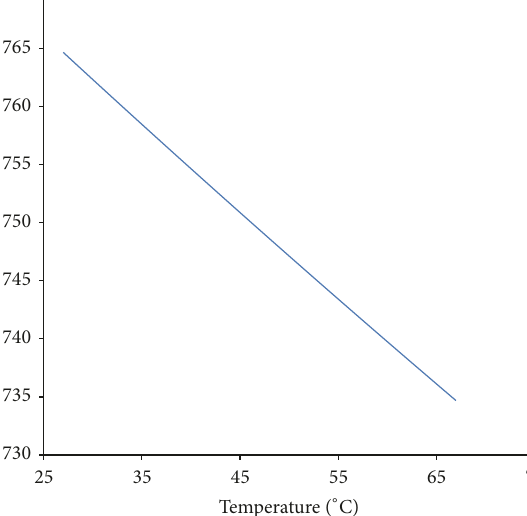
Figure 5: Viscosity of paraffin.